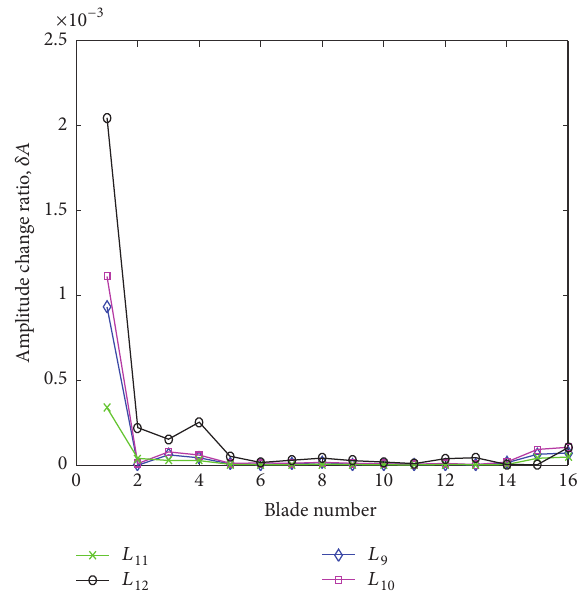
Figure 15: Vibration amplitude changes of MRBs under different 𝑎